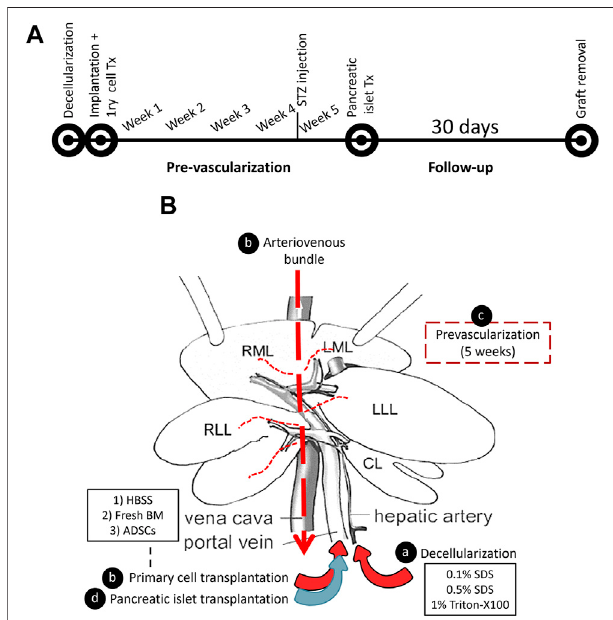
FIGURE 1 | A schematic representation of the decellularized liver pre- vascularizationstudy. (A) Atimeline representing the fl owofthestudy. (B) The graft modulation during the study: (A) the rat liver was decellularized by detergent perfusion through the HA, (B) the decellularized scaffold was implanted into the recipient, and an AV bundle was threaded through the inferior vena cava using a tube that was placed in the IVC. Then, either fresh BMorADSCorHBSSvehiclewasinfusedthroughthePVofthescaffold, (C) a fi ve-week period was allowed for pre-vascularization, and (D) syngeneic pancreatic islets were transplanted through the